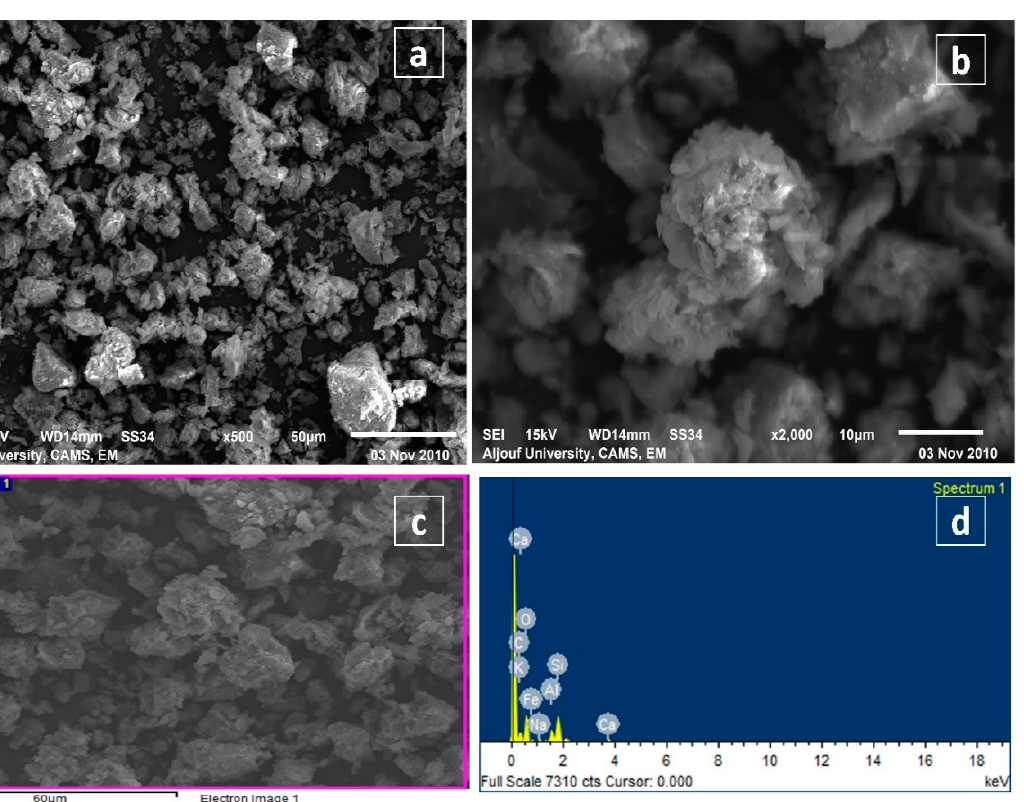
Figure 2. Scanning electron microscopy with the energy-dispersive X-ray spectroscopy (SEM-EDX) analysis of the BT-An@Zetag composite ( a – d